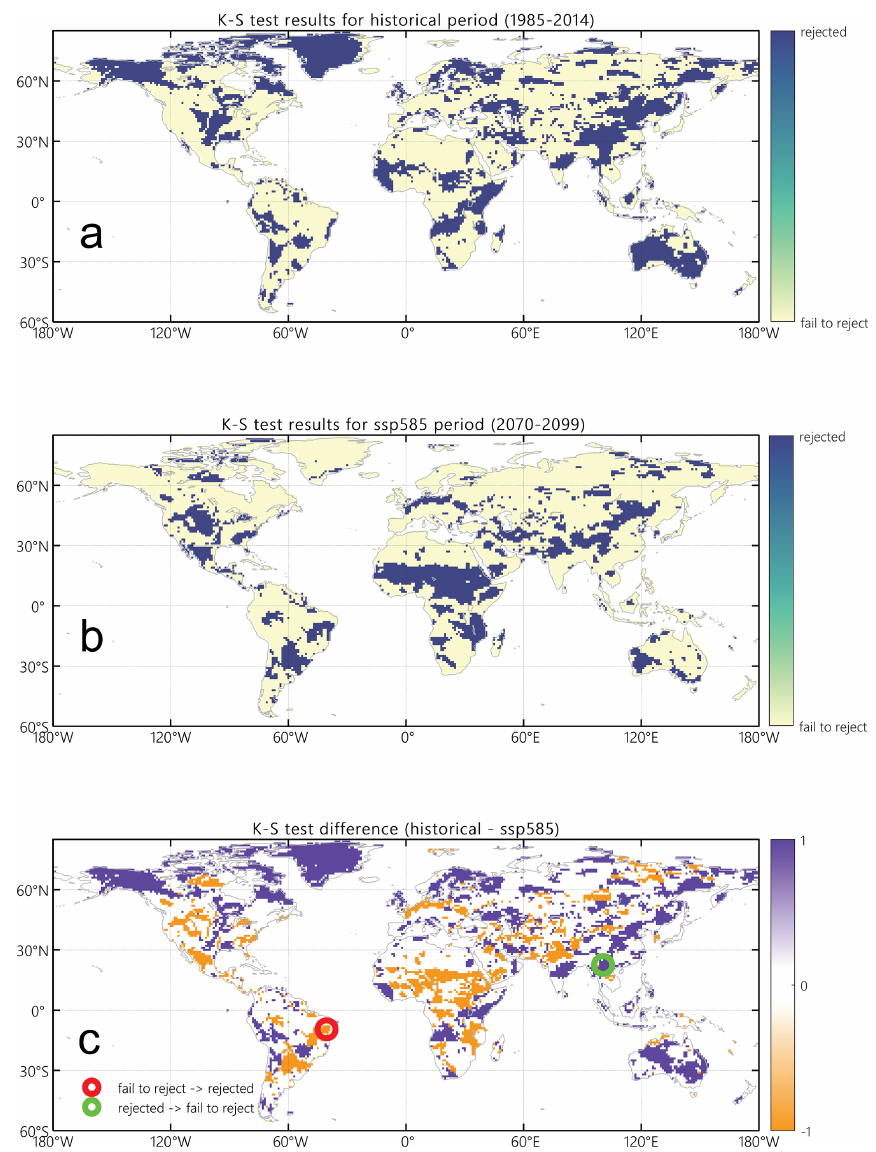
Figure 16. Two-sample K-S test results for mean annual runoff over a (a) 30-year historical period (1985–2014), (b) 30-year ssp585 period (2070–2099), with “rejected” indicating the two samples are not from the same distribution and “fail to reject” indicating the two samples are from the same distribution. The time series and eCDF for two pixels marked with circles in panel (c) are shown in Figs. A3 and